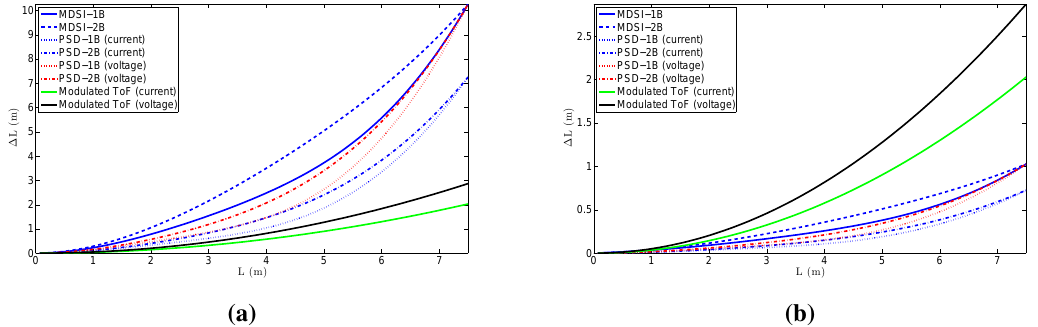
Figure 8. Distance error due to shot noise for the different ToF techniques. In pulsed ToF, T was set to: ( a ) T = 0.5 µ s (10 T